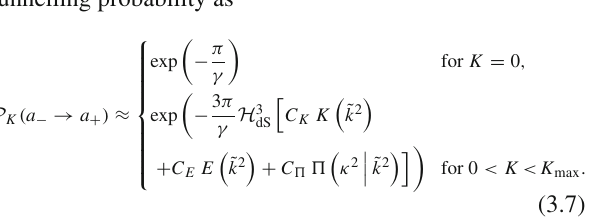
Fig. 4 The tunnelling probability P K ( a − → a + ) plotted as (left) a function of γ for different values of K / K max : (from bottom/darker to top/lighter) K / K max = 0, K / K max = 1 / 4, K / K max = 1 / 2, K / K max = 3 / 4 and K / K max = 99 / 100; and as (right) a function of